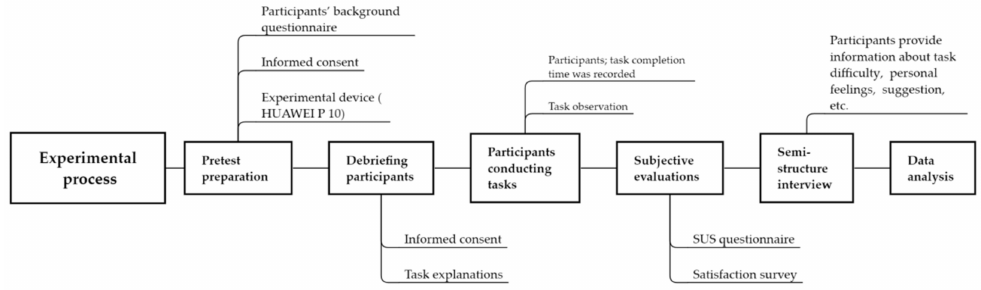
Figure 3. The experimental process of this study.